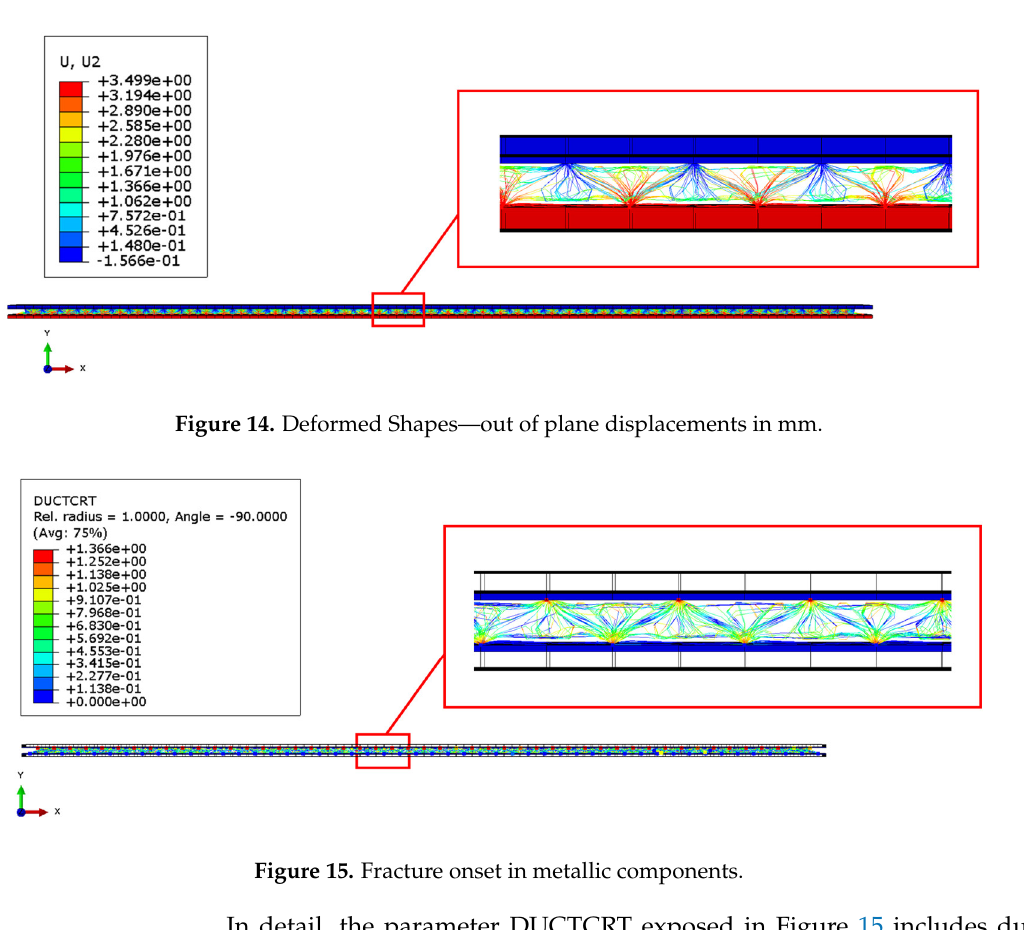
Figure 17. Hashin damage criteria maps for the fibre-reinforced composites skins.